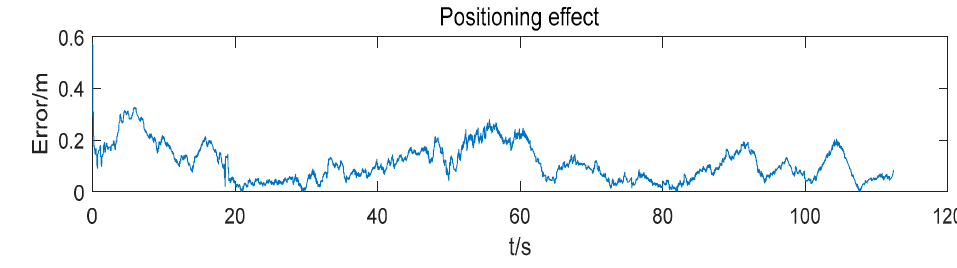
Figure 12. Positioning in an unfamiliar environment.